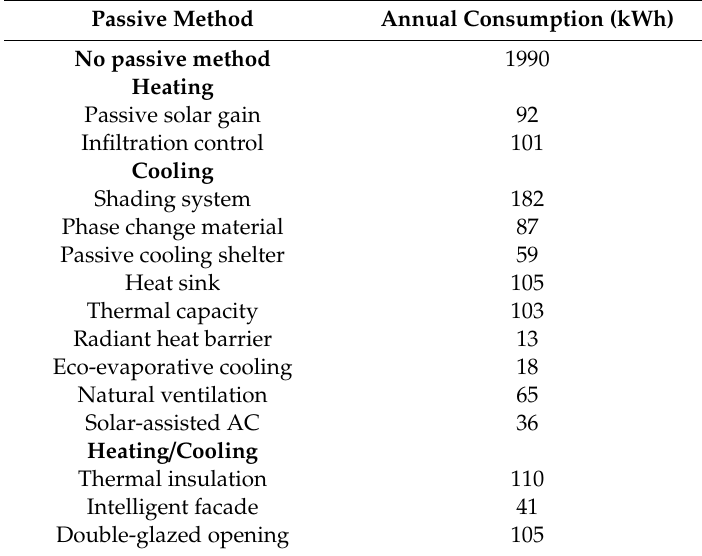
Table 10. Annual energy consumption by using di ff erent passive methods and using operation features by the